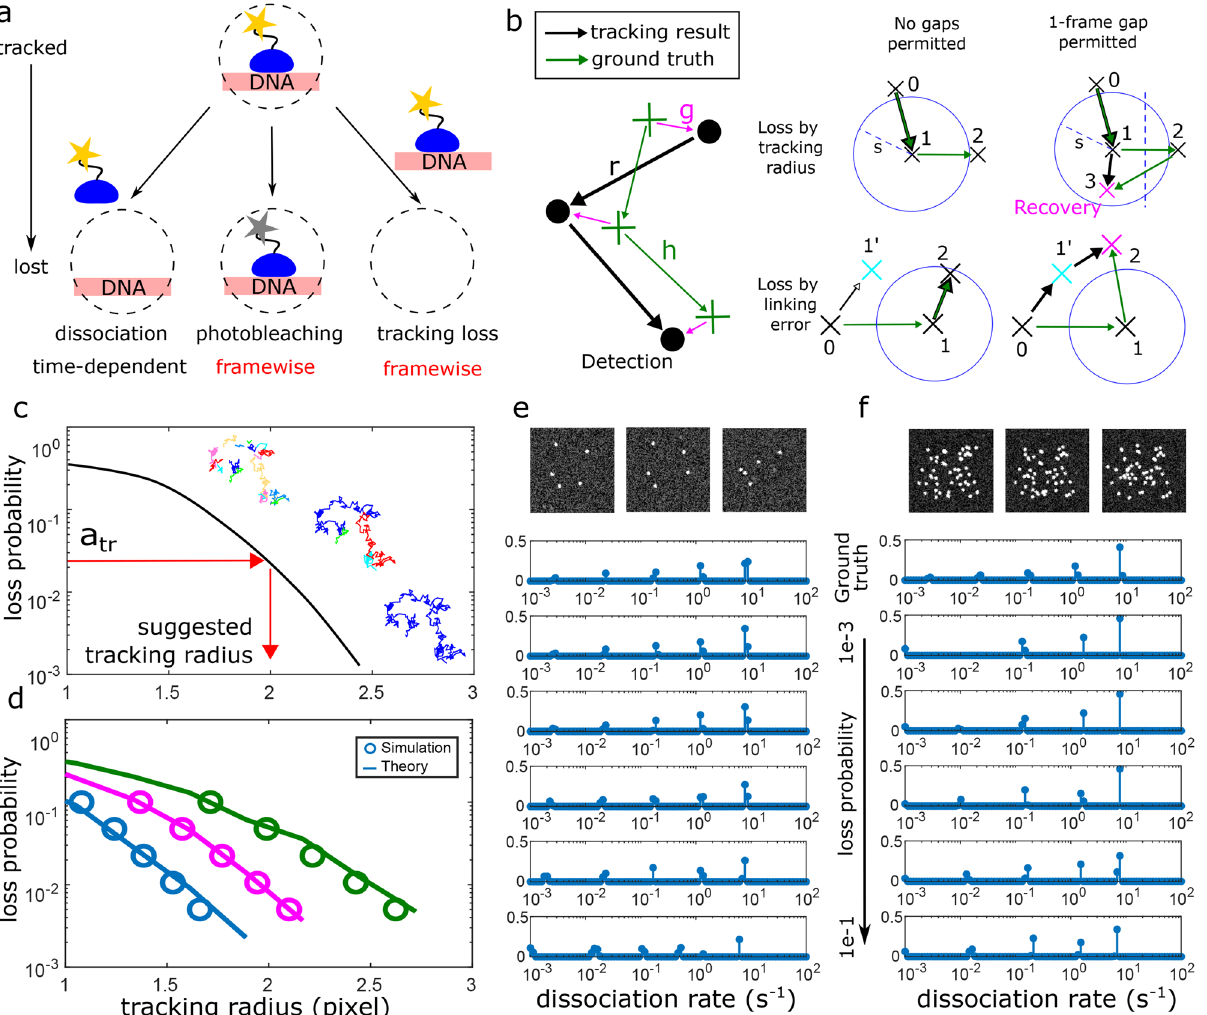
Figure 3. Prediction of loss probabilities in nearest neighbour tracking. ( a ) The track of a bound molecule stops after dissociation, which depends on the laboratory time. Additionally, photobleaching and tracking losses may falsely terminate a track. These losses depend on the frame-cycle time. ( b ) Sketches of tracking losses in the nearest neighbour algorithm. Tracking loss may occur due to jumps out of the tracking radius (s) or erroneous links to a different molecule in close proximity. If one gap frame is allowed, both types of losses can be partially recovered. Recovered tracks retain the correct temporal information, however the spatial properties of the track will be altered. ( c ) Simulated loss probability as function of tracking radius. Large tracking radii increase erroneous links to neighbouring detections, small tracking radii increase losses of the tracked molecule. After each loss a track is split into fragments. The colour coding indicates the different track fragments. ( d ) Comparison of loss probabilities (open circles) of simulated spots tracked with the nearest neighbour algorithm using different tracking radii with loss probability predicted by theory (lines). Three different time-lapse conditions where simulated, with frame-cycle times of 0.05 s (blue), 1 s (magenta) and 5 s (green) (Table 1 Scenario 1). ( e ) and ( f ) Dissociation rate spectra of molecules simulated with five different dissociation rate constants after tracking them using the tracking radii suggested by theory for a given loss probability (Table 1 Scenarios 2 and 3). ( e ) For low densities, dissociation rate spectra are correctly inferred if the loss probability was below 10% per frame. ( f ) For a density of 0.005 Spots per pixel, only fast dissociation rates were recovered in cases of low loss